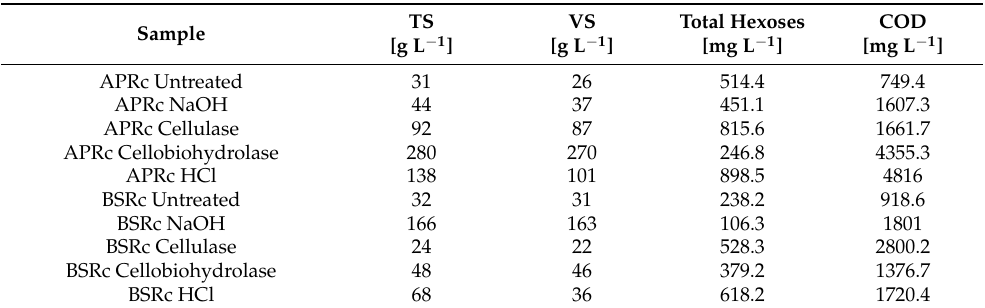
Table 3. Characterization and determination of TS, VS, sugars, and COD of castor residues with and without